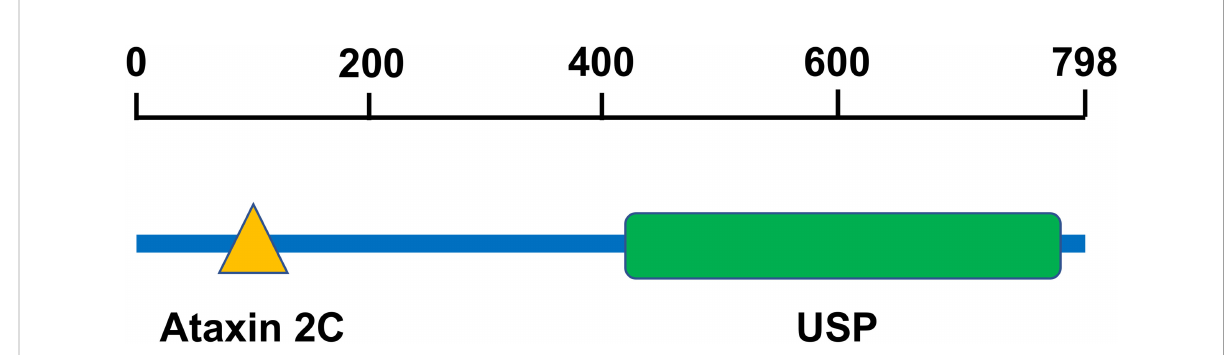
FIGURE 1 The structure of USP10. Human USP10 contains an Ataxin 2C domain and a USP domain. The Ataxin2C domain is approximately 250 residues long, and is located at the C-terminus of eukaryotic ataxin-2. The USP domain consists of a catalytic site, protein-protein interaction sites,